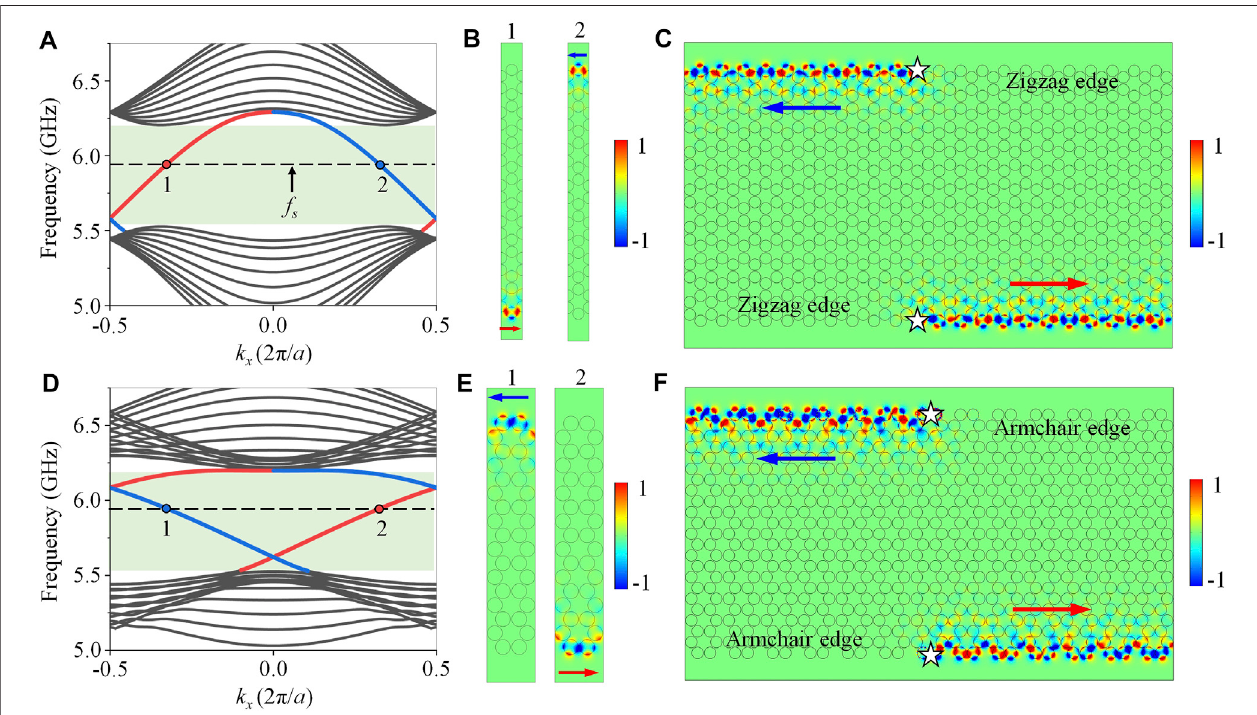
FIGURE2| Topologicalone-wayedgestatesatzigzagandarmchairedgesofarectangularair-holehoneycombGPC. (A – C) Zigzagedges. (D – F) Armchairedges. (A, D) Projected band structures. (B, E) Eigenmodal fi elds. (C, F) Electric fi eld distributions. Blue and red arrows indicate the left- and right-propagating one-way edge statesrespectively,andwhitestarsrepresentthelinesourcesoscillatingatafrequencyof f s (cid:1) 5.90 GHz.Thefrequencyattheblackdottedlinesis f s (cid:1) 5.90 GHz,andthe bandgap are marked as the greed region with a frequency range of 5.52 ∼ 6.21 GHz.